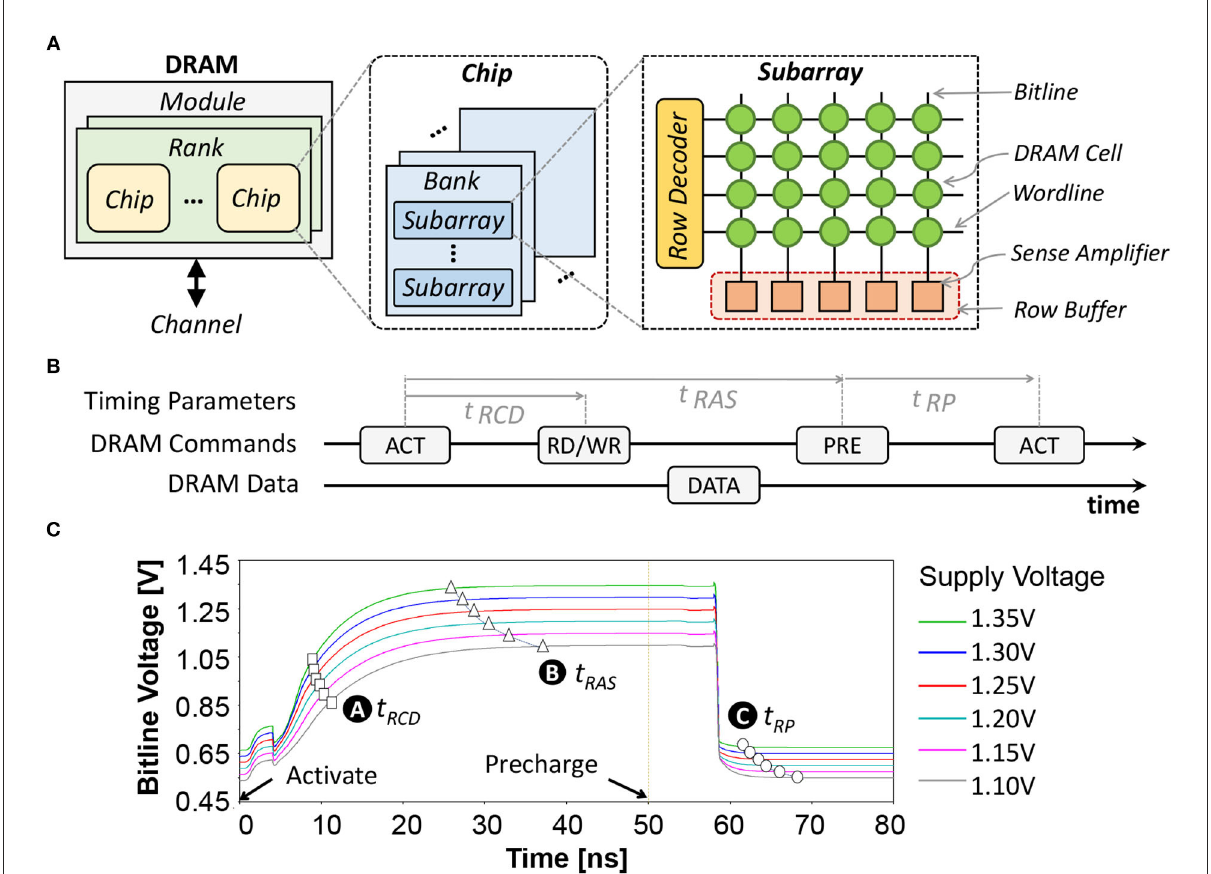
FIGURE4 (A) The internal organization of commodity DRAM. (B) Diagram of the DRAM commands (i.e., ACT, RW or WR, and PRE) and the DRAM timing parameters (i.e., t RCD , t RAS , and t RP ). (C) The dynamics of the DRAM bitline voltage V bitline and the respective timing